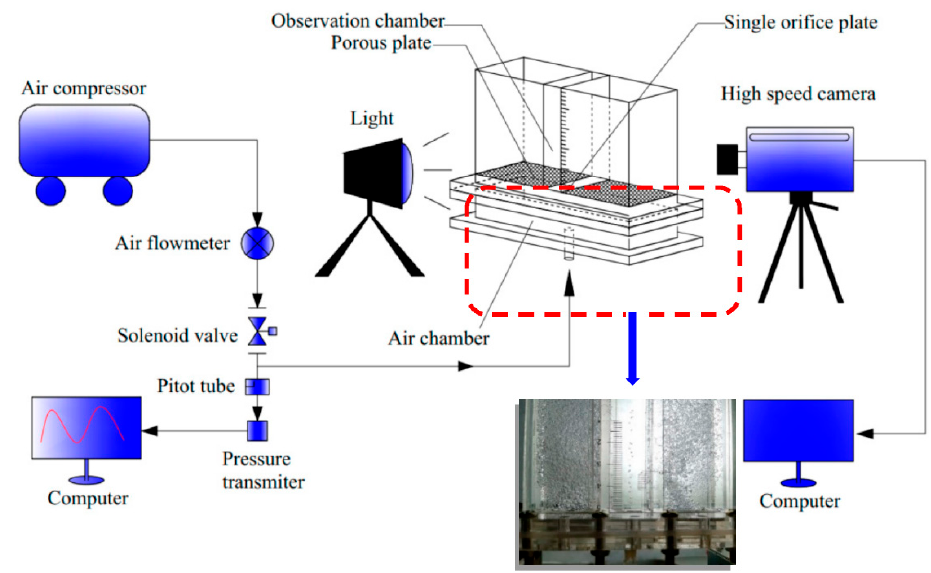
Figure 1. A schematic of the experimental setup.